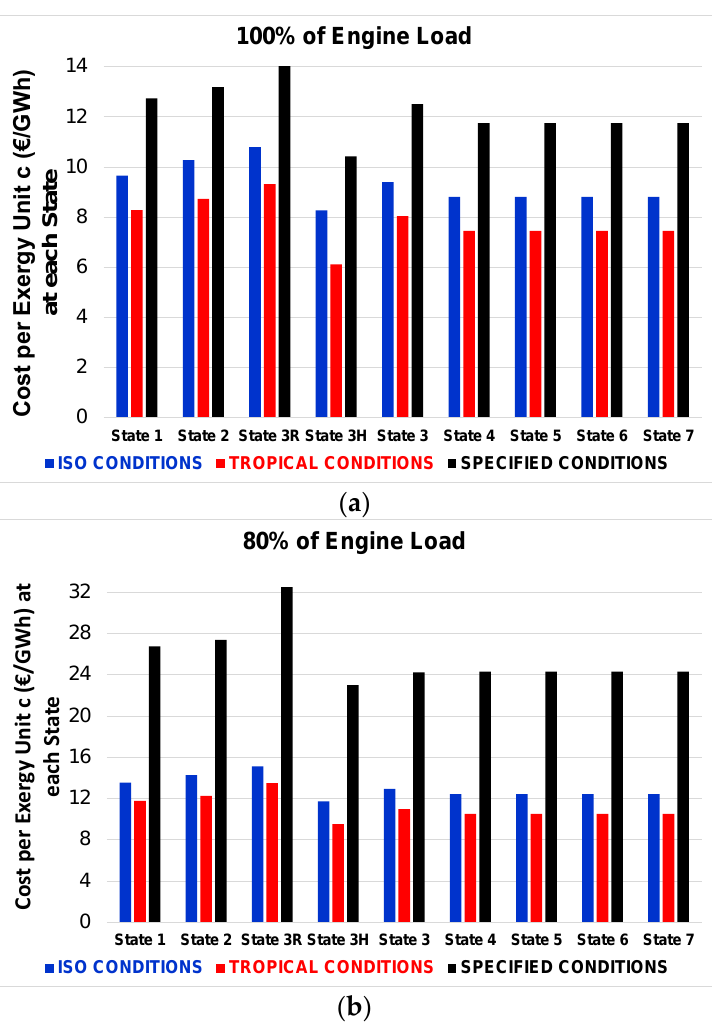
Figure 15. Variation of cost per exergy unit at each state at ( a ) full engine load and ( b ) 80% of full engine load for ISO, tropical, and specified